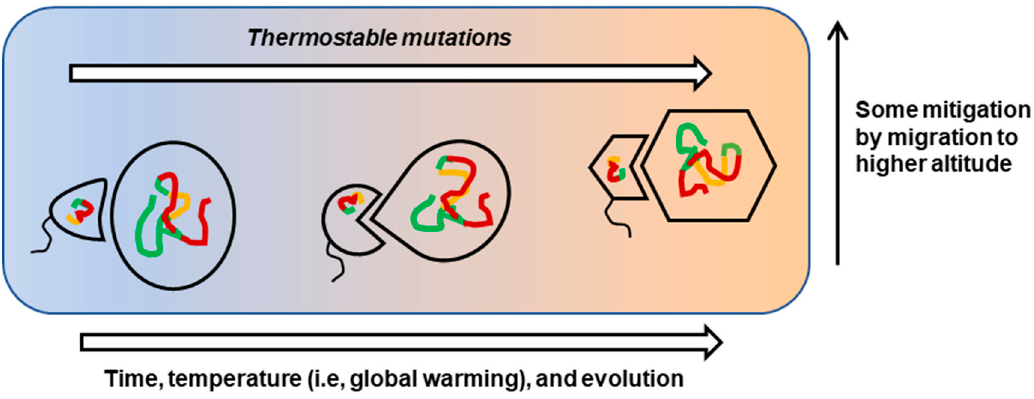
Figure 5. Selection for thermostable mutations, as well as mitigation by organismal behavior and habitat (range) change, in global warming. A pathogen (the smaller structure with flagella) and its host (the larger structure) are shown as a pair, to indicate that they will mutate together, with increasing temperature, as time passes. The changes are indicated by the altered structure of the protein (shown in three colors for the domains, to match Figure 3) and possibly by altered morphology. Simultaneously, the organisms may migrate to higher habitats, for a cooler atmosphere.